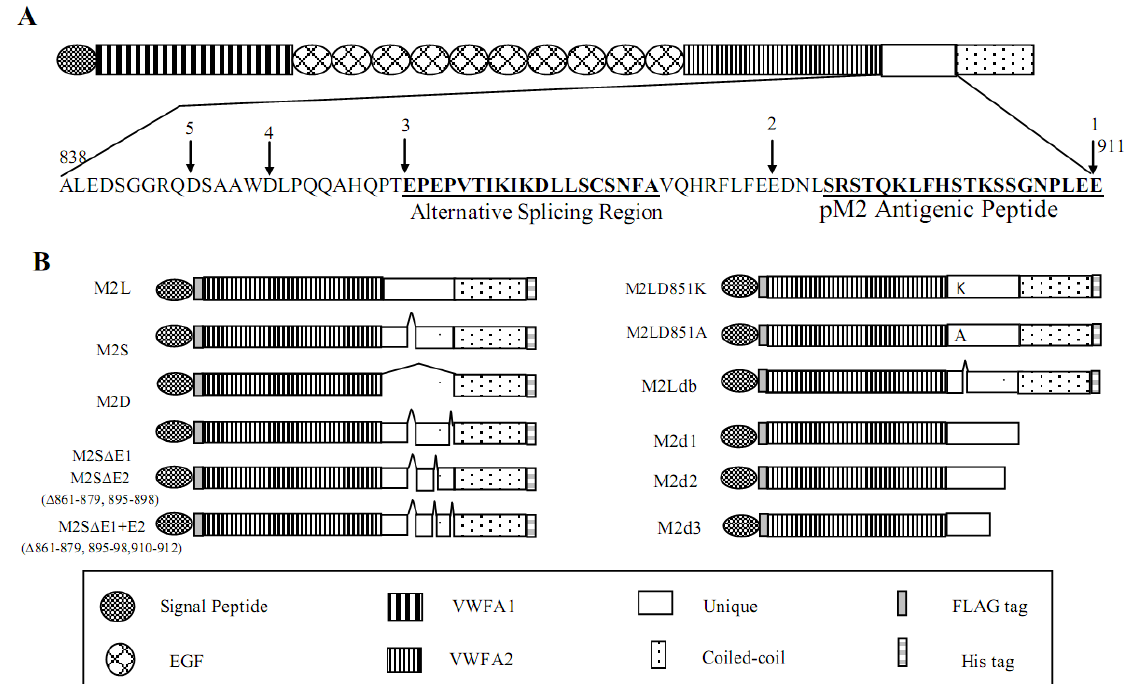
Figure 3. Diagram of matrilin-2 and its cDNA constructs. ( A ) A schematic diagram of matrilin-2 and the amino acid sequence of the unique domain. Alternative splicing region and the antigenic peptide for generation of anti-matrilin-2 antibody were indicated. The numbers correspond to different truncation sites within the domain. ( B ) Matrilin-2 cDNA constructs with deletions and mutations in the unique domain. M2L(Long) contains the entire unique domain (A 838 to E 911 ). M2S(Short) contains the short form of the unique domain without the alternative splicing region (E 861 to A 879 ). M2D(Deleted) has the entire unique domain deleted. M2d1, M2d2, M2d3 were matrilin-2 truncated products in which the stop codon was added after E 911 (position 1), E 888 (position 2), E 861 (position 3) in M2L respectively. Position 4 between D and L is the putative unique ADAMTS cleavage site in matrilin-2, while position 1 between E 911 and S 912 is the second putative ADAMTS cleavage site, similar to the sites in other